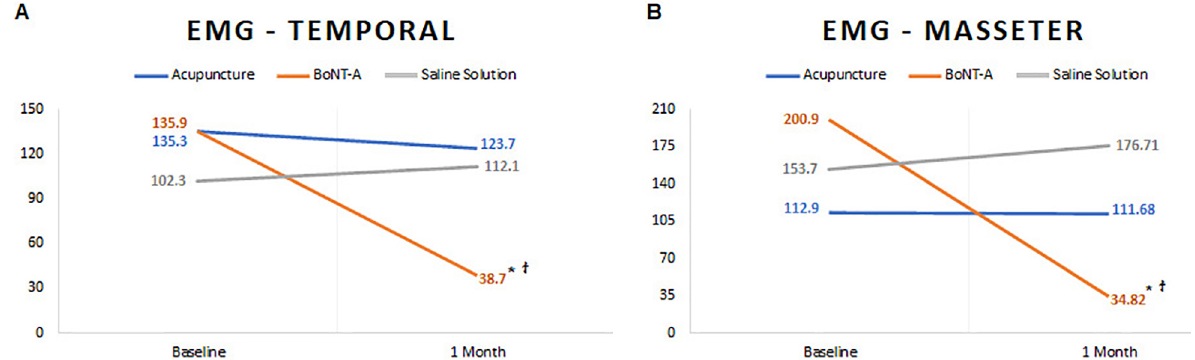
Figure 4- Root mean square scores (RMS μV) of maximum volunteer contraction for each group, before and after treatments. A, anterior temporal muscles mean values; B, masseter muscles mean values. ϯ represent significant differences among groups (P<0.05); * represent significant differences among time points